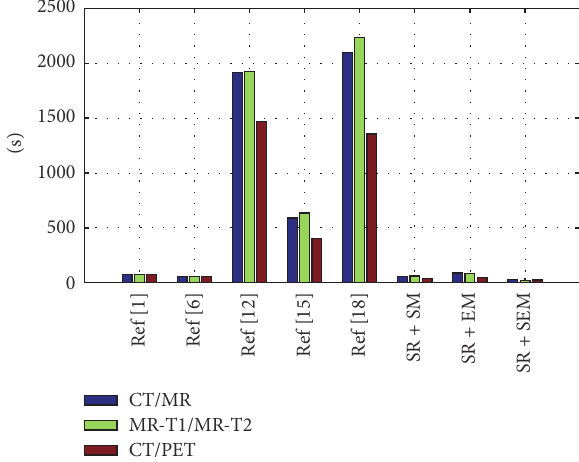
Figure 8: The time consuming of different fusion